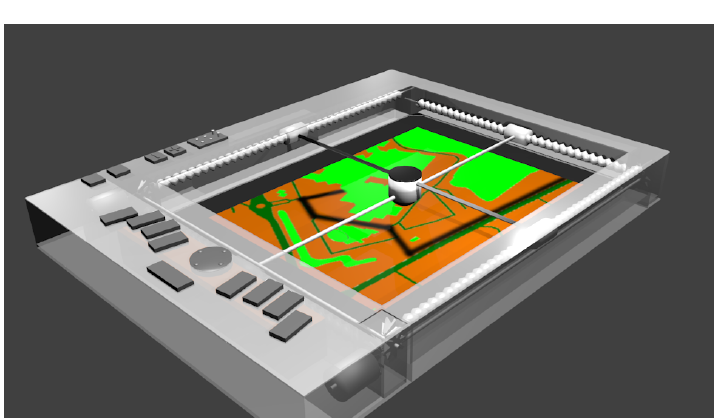
Figure 4. F2T model design (with the simplified map of Rouen Normandy